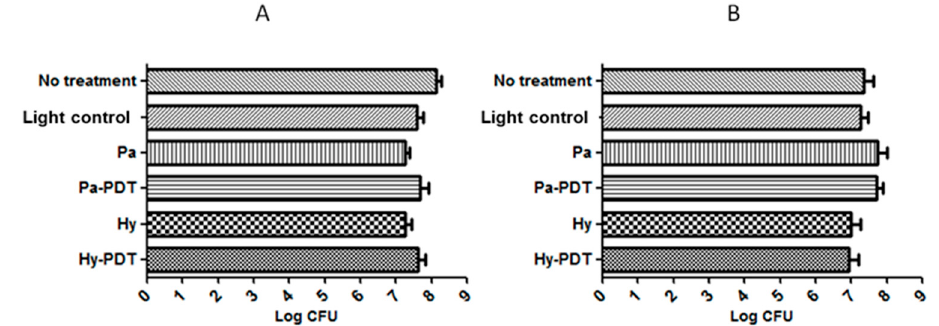
Figure 4. Bacterial load of wounds in different groups of mice after intravenous injection treatment with or without PDT. ( A ) Pa and Hy 2.5 mg/kg, irradiation for 30 s for PDT groups; ( B ) Pa and Hy 2.5 mg/kg, irradiation for 10 min for PDT groups. Data are mean ± SEM ( n = 5).